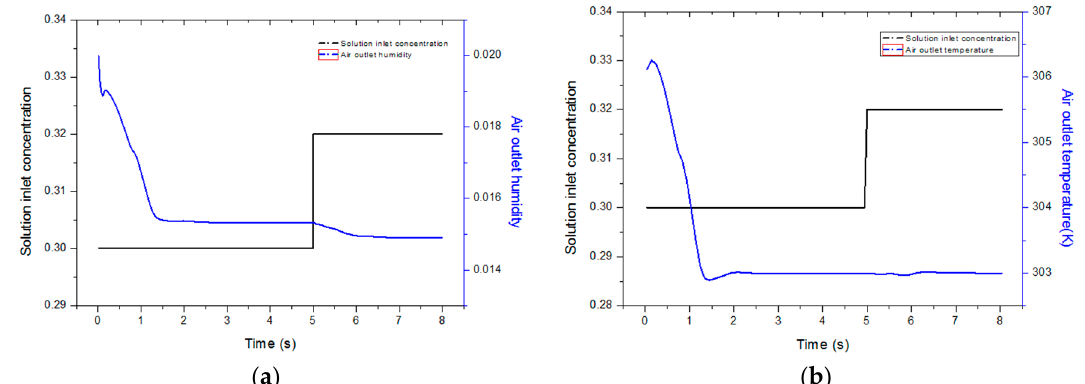
Figure 5. Humidity and temperature variation under step change of solution concentration. ( a ) air outlet humidity; ( b ) air outlet